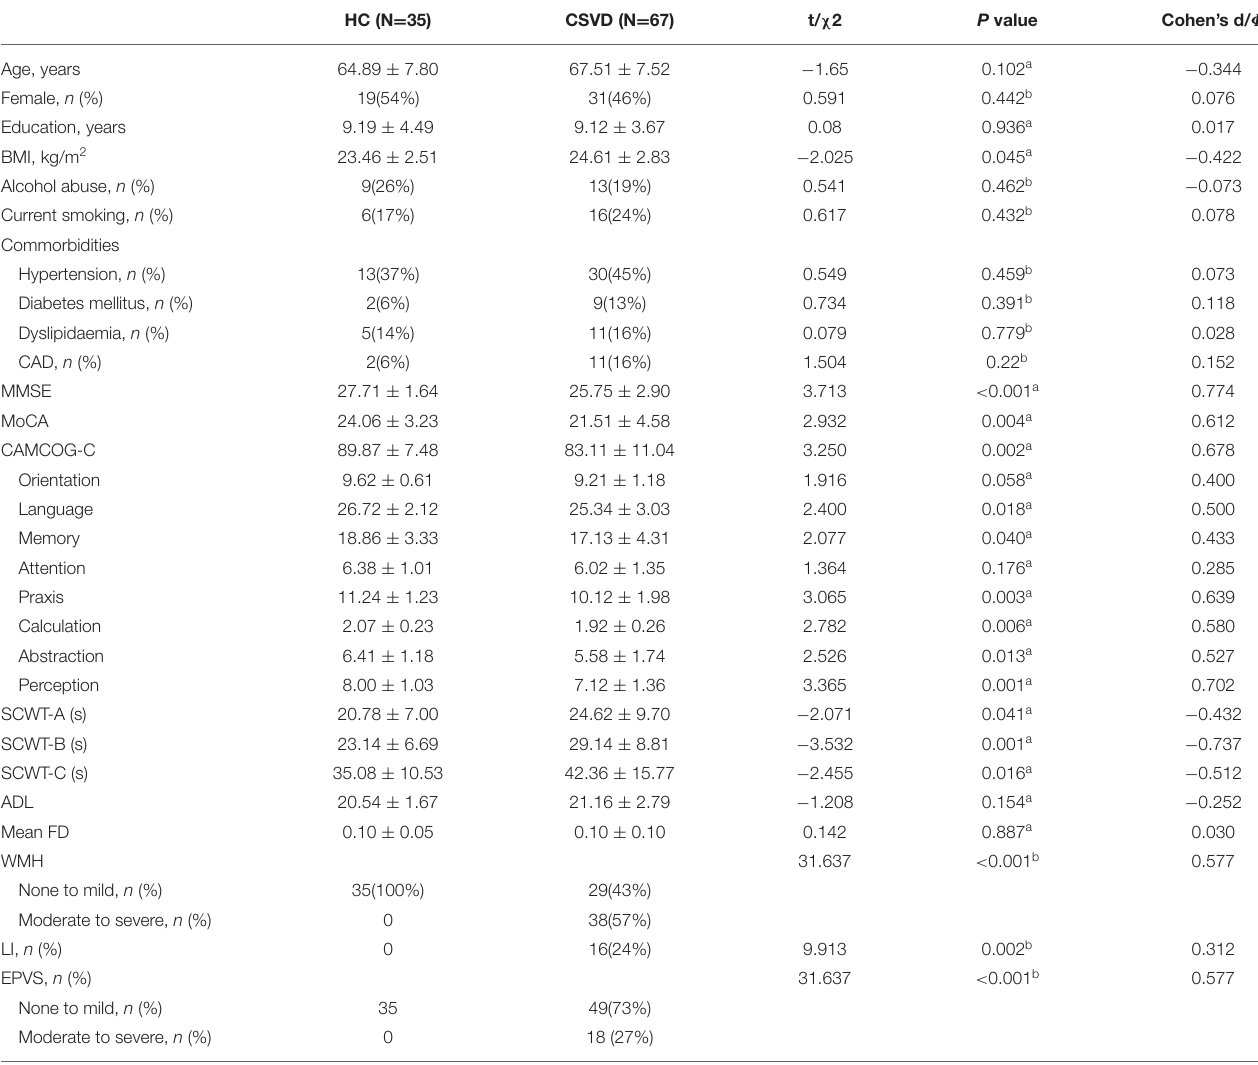
TABLE 1 | Demographic and clinical data of the CSVD and HC